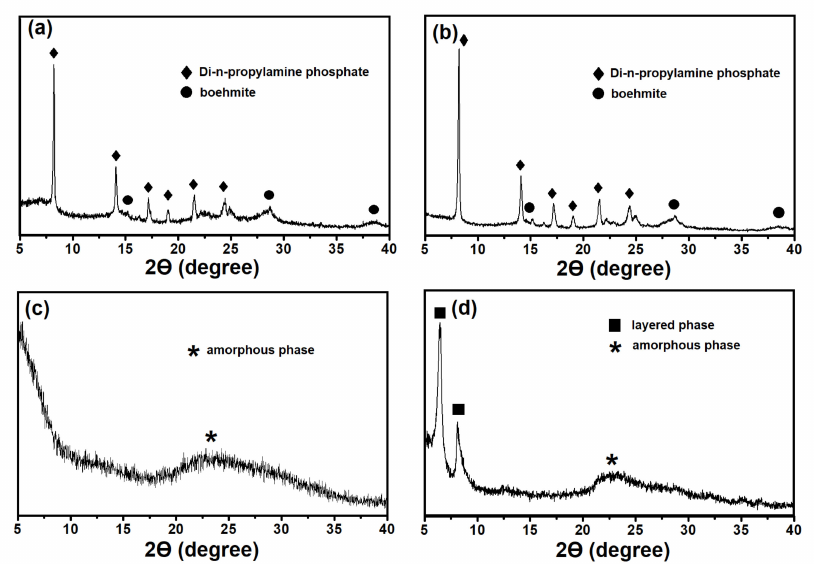
Figure 1. X-ray diffraction patterns of the silicoaluminophosphate gels: ( a ) Sample SAPO-PB-1.0; ( b ) Sample-SAPO-PB-1.5; ( c ) Sample-SAPO-iAl-1.0; ( d )